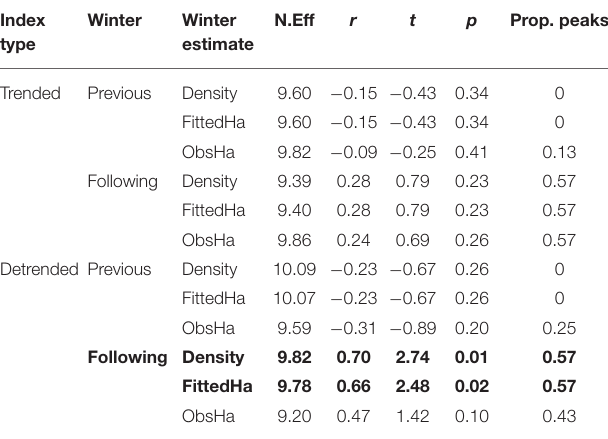
TABLE 3 | Spearman correlation (N.Eff, effective sample size after accounting for temporal autocorrelation of indices; r, correlation coefficient; t , t- value; p , p -value) and proportion of corresponding maxima and minima (Prop. peaks) of breeding annual indices estimated using Ontario Butterfly Atlas data with overwintering population estimates (density, fitted Hectares, and observed hectares) for the winter previous and following the breeding season, and using raw and de-trended annual